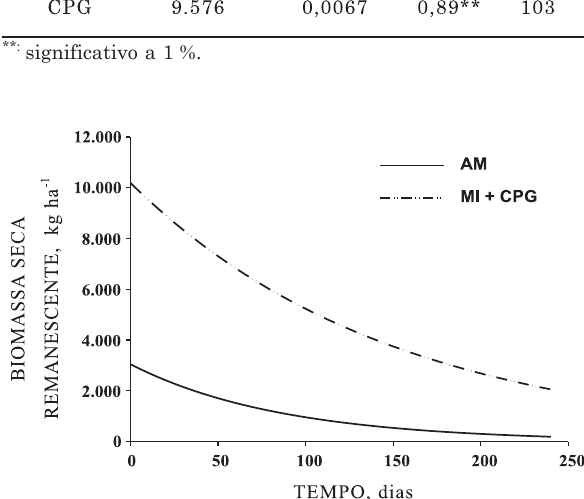
Figura 2. Biomassa seca remanescente dos resíduos culturais das plantas de amaranto (AM), milheto (MI) e capim-pé-de-galinha (CPG), até 240 dias após o manejo